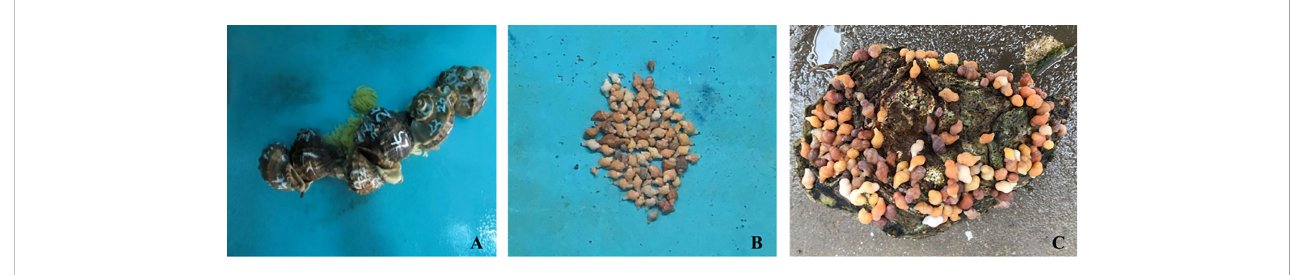
FIGURE 1 Gastropod aggregation behavior: (A) reproductive aggregation of Rapana venosa (Shell height 6 ± 1 cm) and (B) adaptive and (C) predator – prey aggregation of Neptunea cumingii (Shell height 1 ± 0.3